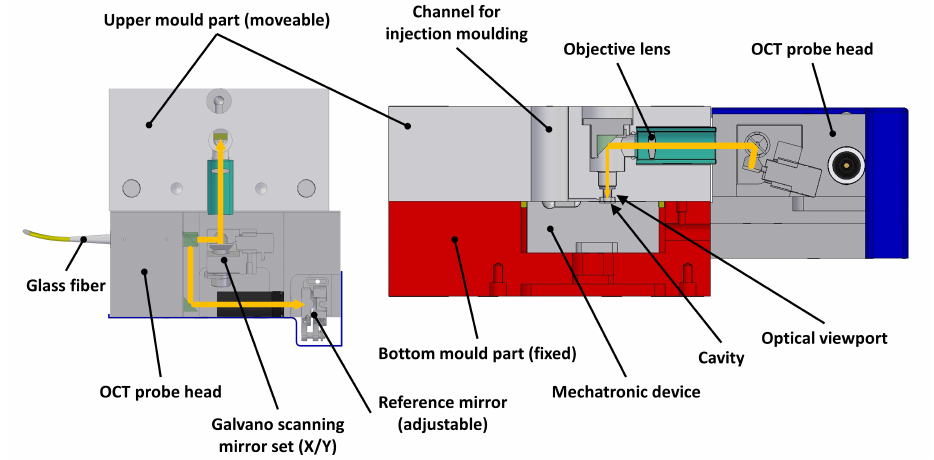
Figure 3. Cross-sectional views of the probe head. The beam path is indicated by the orange line, with a view from the top ( left ) and a view from the side ( right ). The optical elements that are inside the movable mould part are the objective lens, right angle prism mirror and sapphire glass viewport.